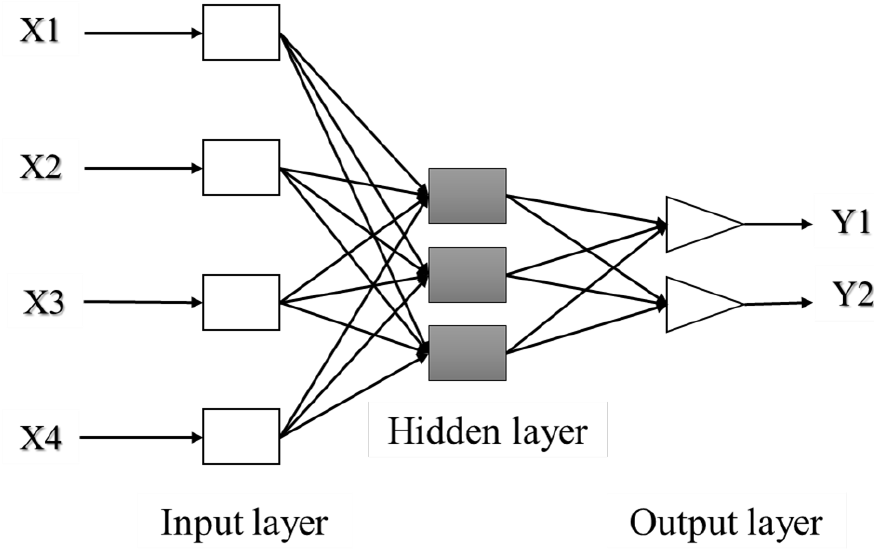
Figure 5. Feed-forward network structure. Adapted from Agatonovic-Kustrin and Beresford [137]. Recurrent (or feedback) networks are considered as a dynamic system where